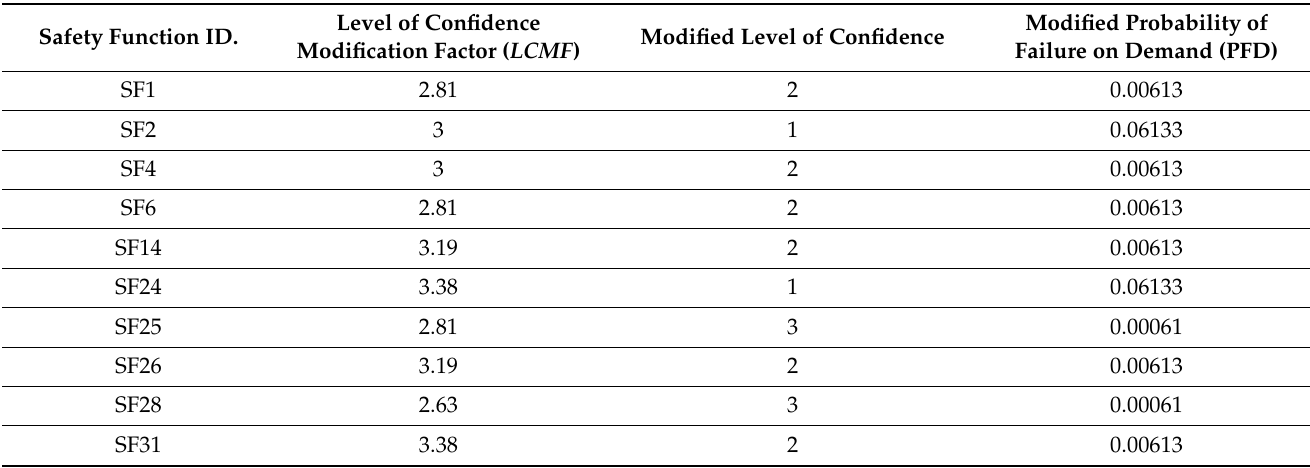
Table 8. Modified Level of Confidence (LC) for a Management Modification Factor ( MMF ) indicating high management performance, i.e., Score of the Management Modification Factor ( SMMF ) = 1.5. Safety Function ID.